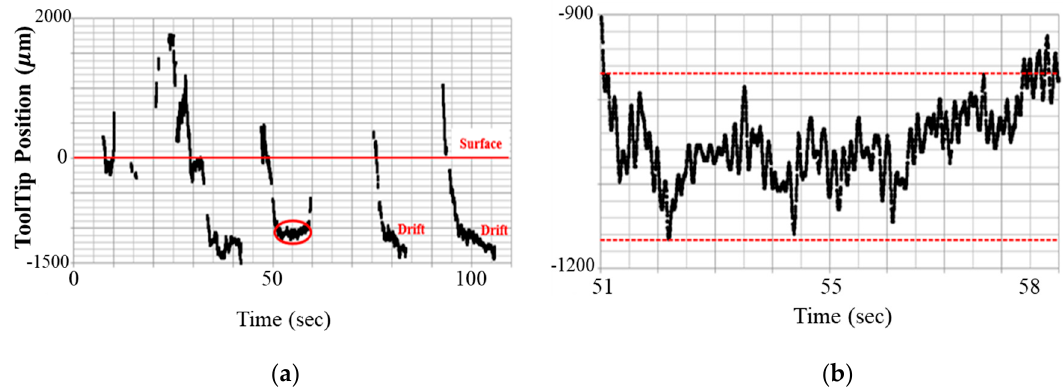
Figure 1. Free hand insertion test performed by a retinal surgeon: ( a ) Needle tip position tracking data during the insertion trial, ( b ) a magnified area in red ellipse of graph ( a ). The two red dotted lines mark the range of insertion depth variation during the microinjection.